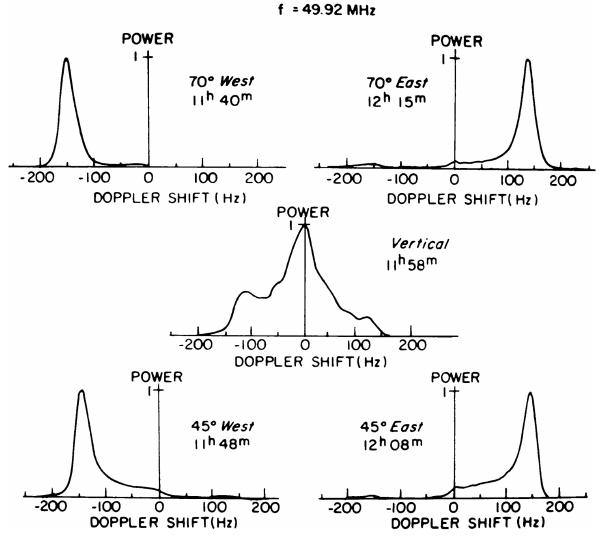
Fig. 8. Early Doppler spectra observations at Jicamarca at vari- ous zenith angles during a strong electrojet showing both type 1 and type 2 echoes. Note that the position of the echo peaks for the oblique echoes is nearly independent of zenith angle (from Cohen and Bowles, 1967).